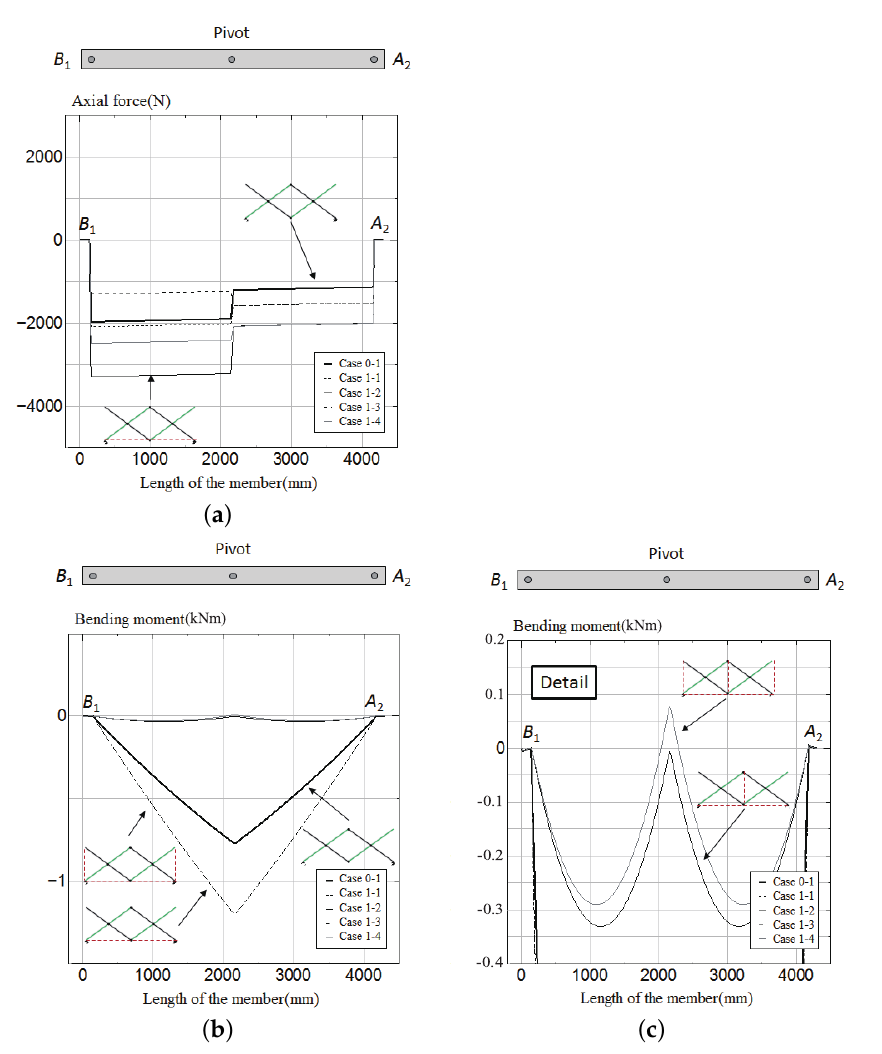
Figure 9. Change of sectional force distributions for member B 1 A 2 in Case 1: ( a ) AFD; ( b ) BMD; ( c ) Close-up of